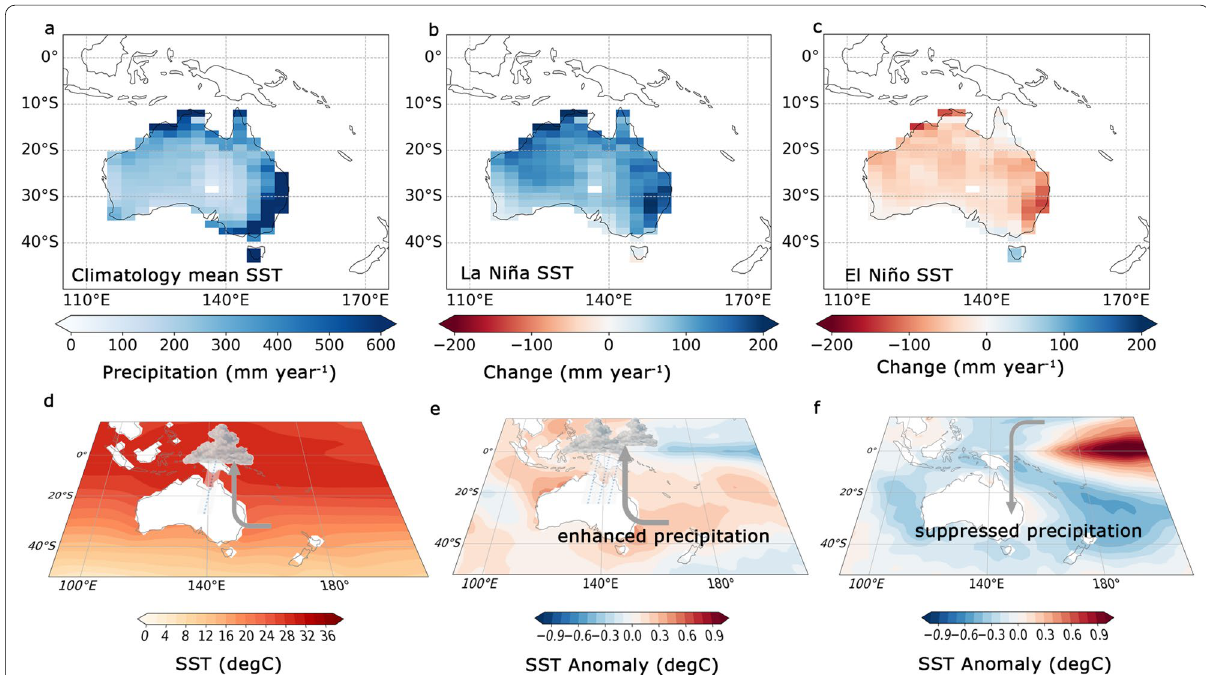
Fig. 2 Changes in precipitation under different SSTs. a The mean annual precipitation under the climatology mean SST condition. b , c Changes in mean annual precipitation for La Niña and El Niño SST forcing conditions extracted by the pattern of the climatology mean SST, respectively. d – f The conceptual illustrations of precipitation associated with different SST forcings. d Convection from the western Pacific (east of Australia) contributes to the precipitation on the continent. e Anomalous warm SST tends to enhance more precipitation in Australia. The SST anomaly is computed as the La Niña mean SST minus the climatology mean SST. f The anomalous cold SST under the El Niño condition suppresses the precipitation in